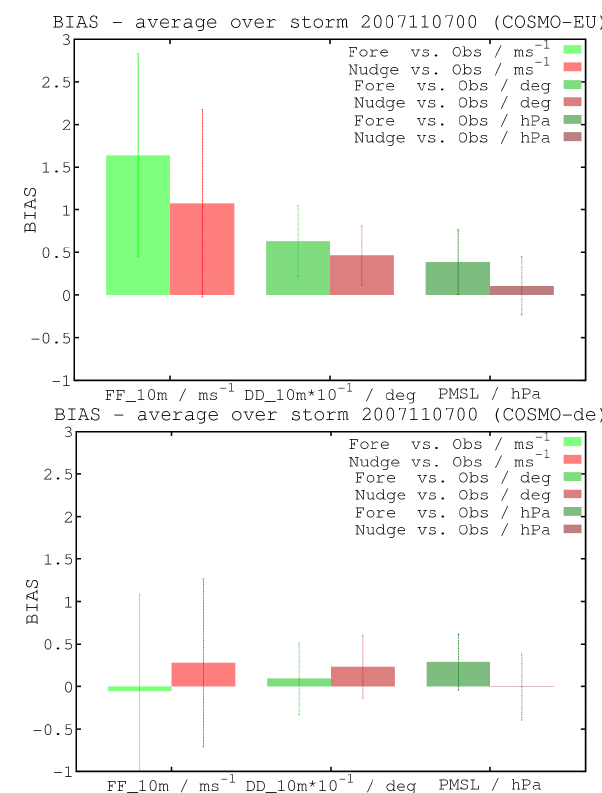
Fig. 4: The biases and uncertainties of the biases for storm ”Tilo” for the three variables v 10m, dd 10m and pmsl for for the three variables v_10m, dd_10m and p.m.s.l. for COSMO-eu and COSMO-de and both for nudging runs (red) and runs without COSMO-eu and COSMO-de and both for nudging runs (red) nudging (green). At the top the biases for COSMO-eu and at the and runs without nudging (green). At the top the biases for bottom the biases for COSMO-de are shown. COSMO-eu and at the bottom the biases for COSMO-de are shown.